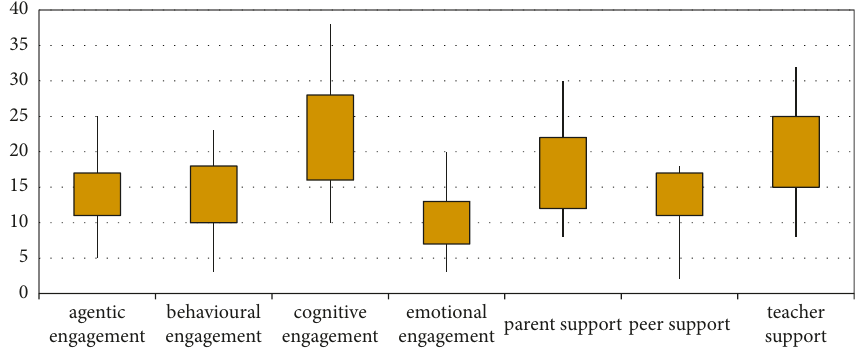
Figure 1: Box plot for the latent